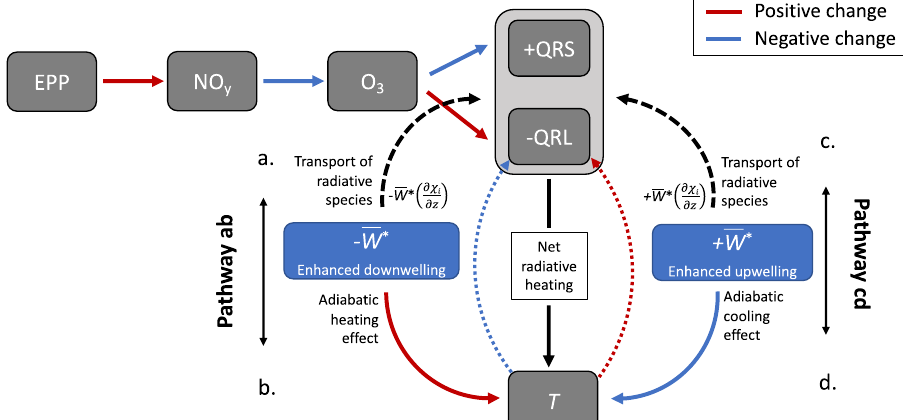
Fig. 2 | Chemical and dynamical heating contributions in the stratosphere. Schematic diagram of the potential interactions between chemical and dynamical heatingcontributionstotemperature T ,asaresultofchangestoozone(O 3 )andup/ downwelling.Redarrowsindicateanincreasingeffect,whilebluearrowsindicatea reducingeffect.EPPisenergeticparticleprecipitation,NO y isnitrogenfamily(NO x ,